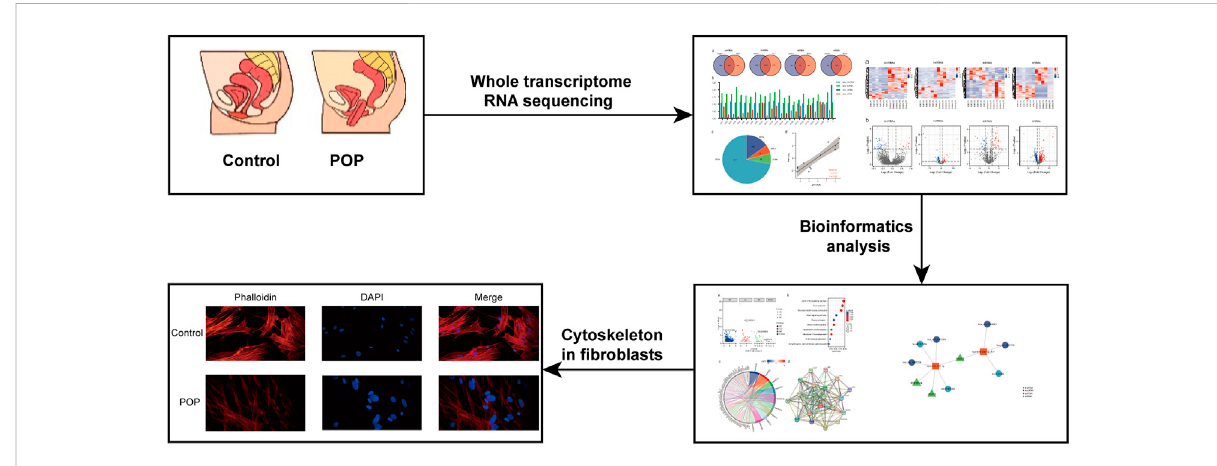
FIGURE 1 Research strategy employed in the present